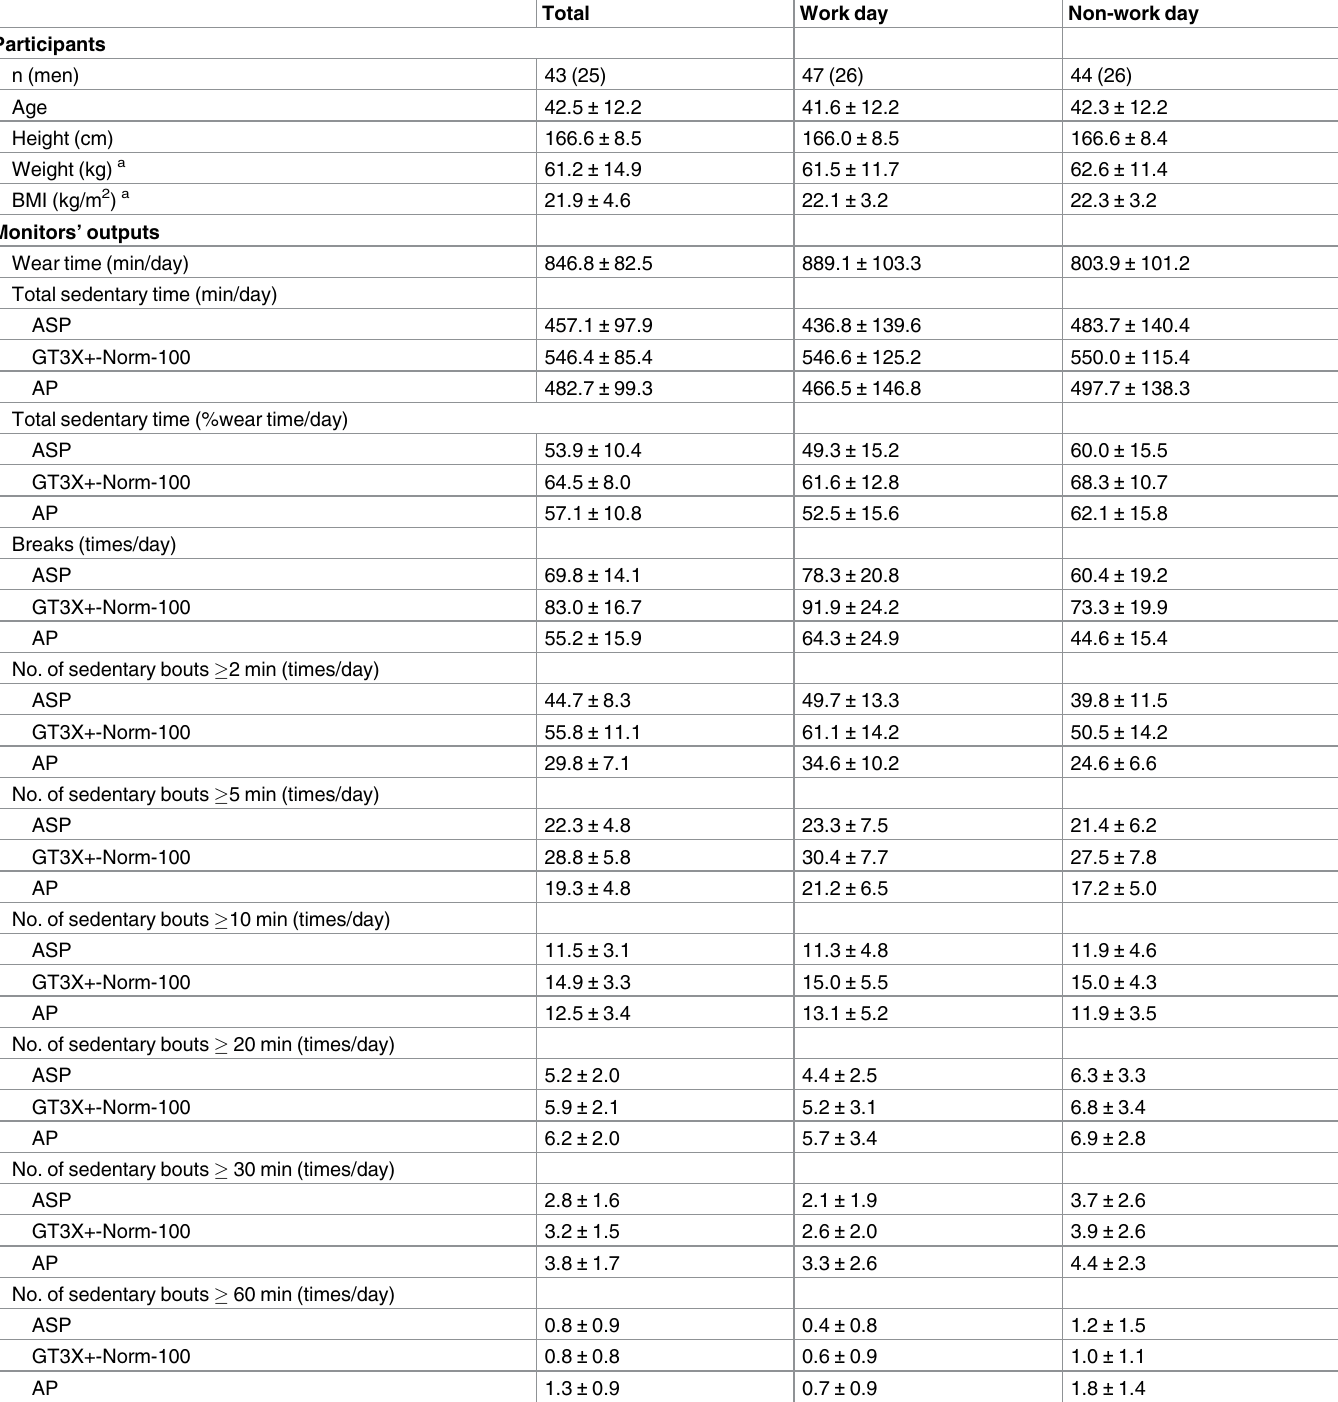
Table 1. Participants’ characteristics and descriptive statistics of monitors’